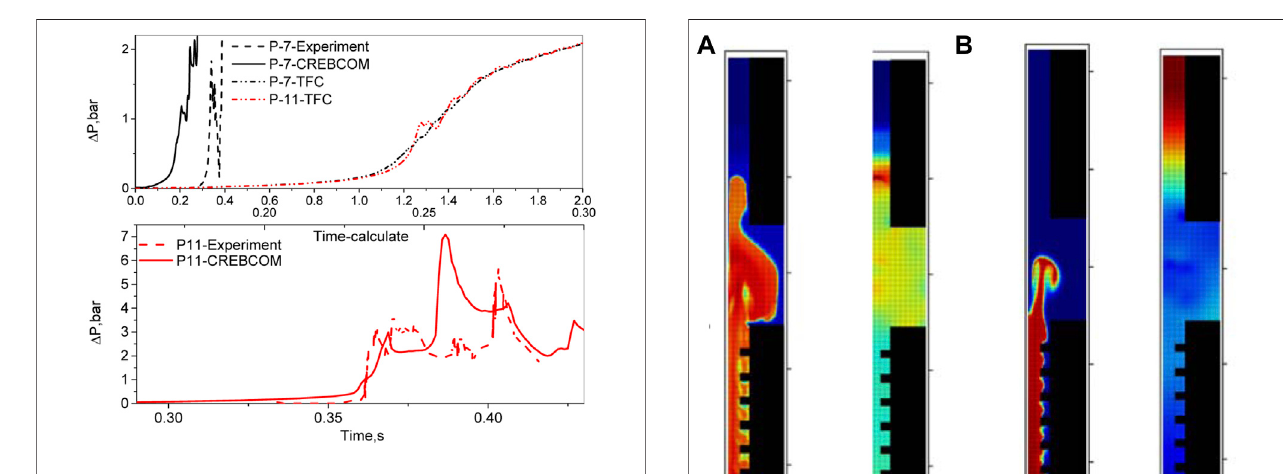
FIGURE 3 | Pressure of P7 and P11 of RUT test sth6 — Experiment vs. CREBCOMandTFCmodel(E fi menkoandDorofeev,2001;Studeretal.,2013).